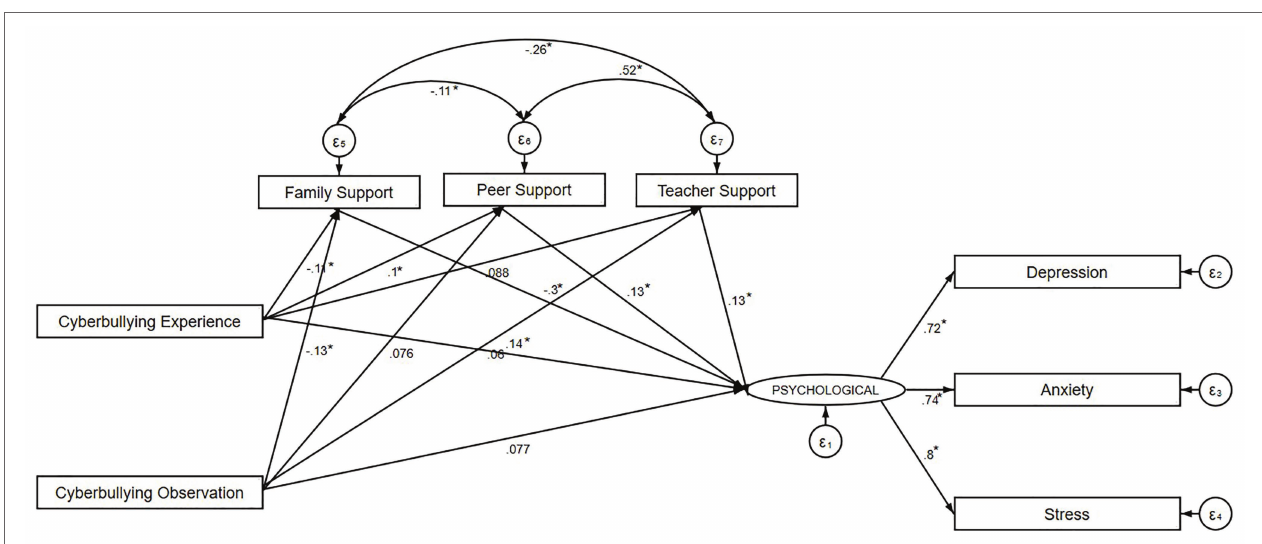
FIGURE 2 | Mediation model of cyberbullying experience and observation on psychological health via social support. The model shows the standardized estimates for direct effects, the covariance between mediators, and dependent variables. * p <